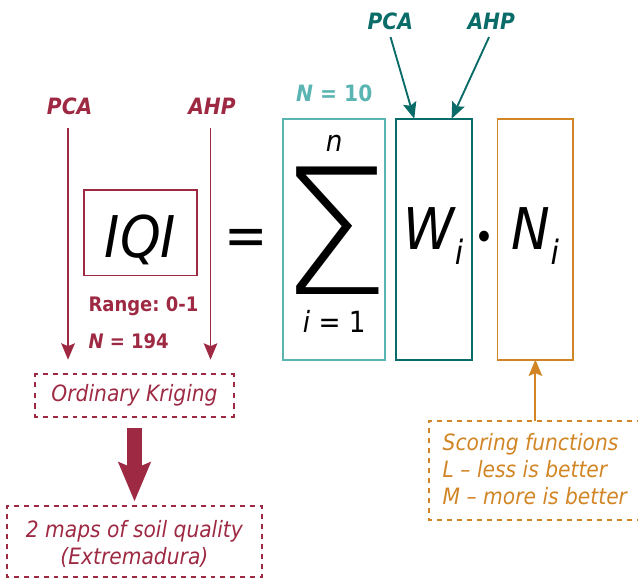
Figure 2. Work scheme and rationale based on the IQI equation (Qi et al.,